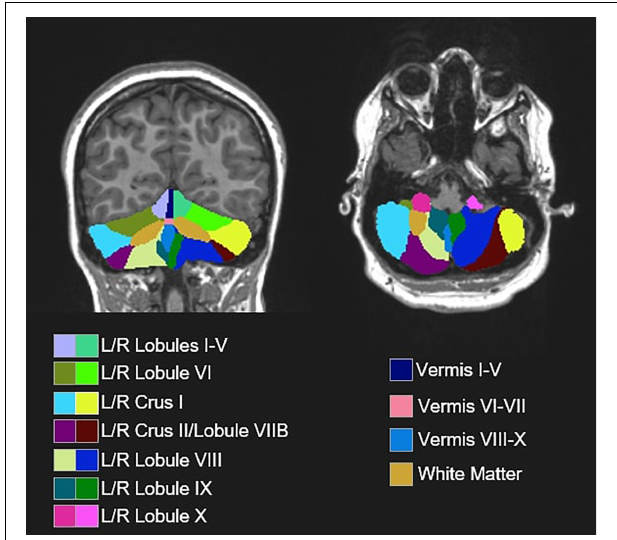
FIGURE 2 | Representative segmentation from a single subject depicting 18 cerebellar ROIs obtained from automated segmentation procedures (ACAPULCO; Han et al., 2020) and an accompanying pediatric template (Carass et al.,